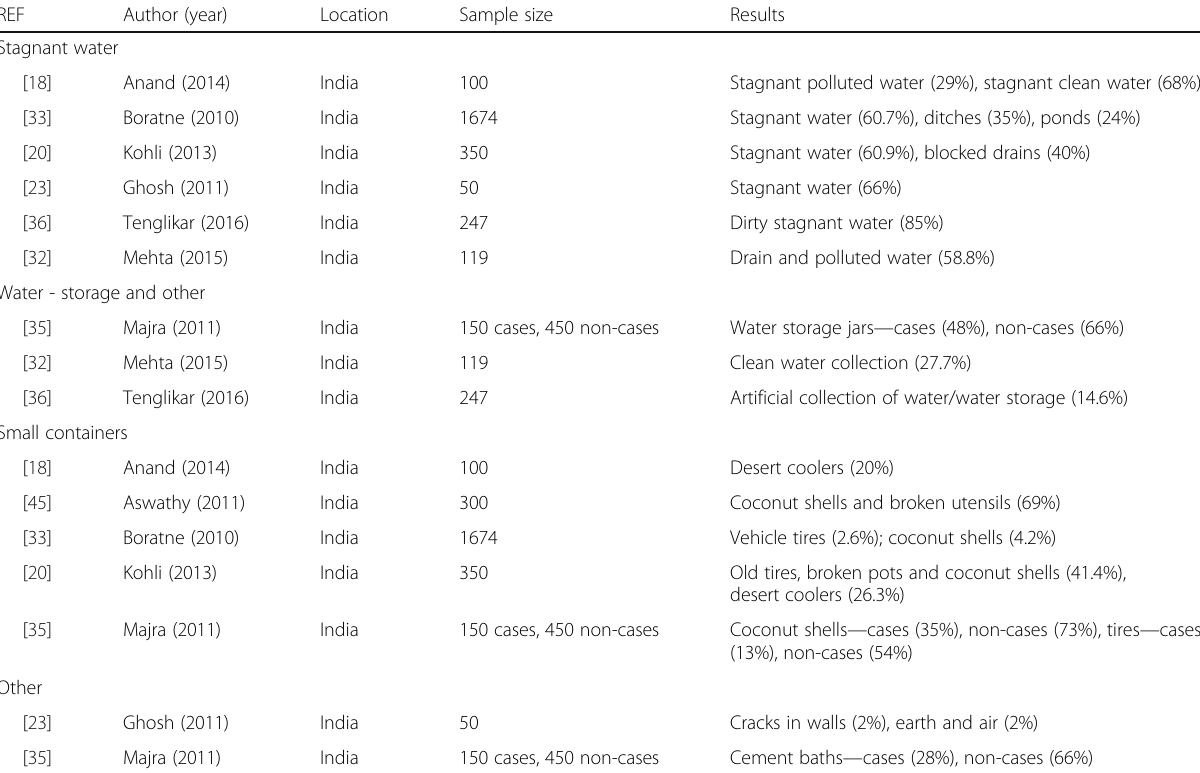
Table 3 General public ’ s knowledge on mosquito breeding sites REF Author (year)